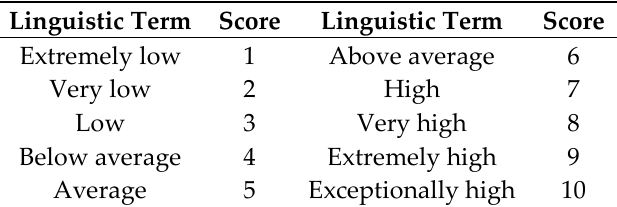
Table 6. Linguistically define criteria scores.